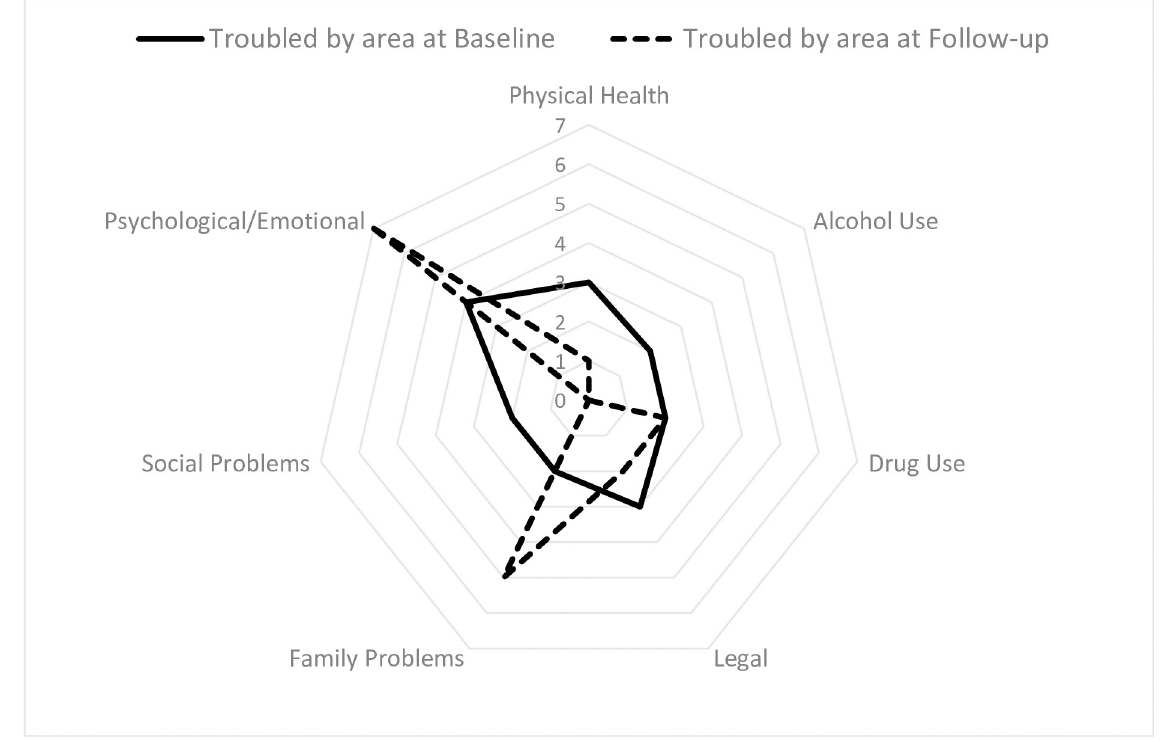
Fig 1. Number of clients reporting being “Troubled by” each ASI category at baseline and follow-up.